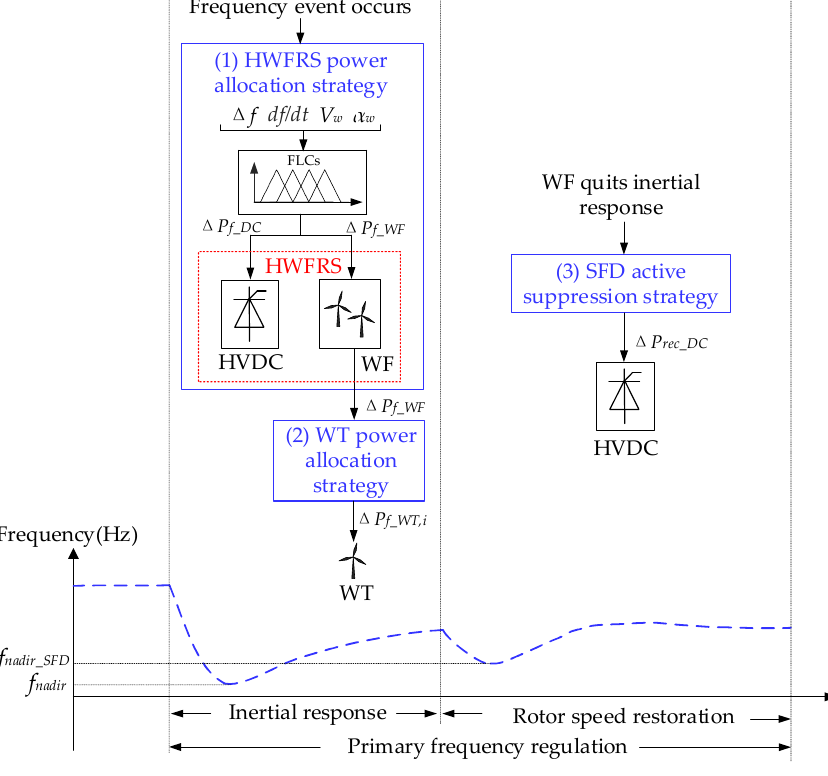
Figure 6. HVDC-WF frequency coordinated control